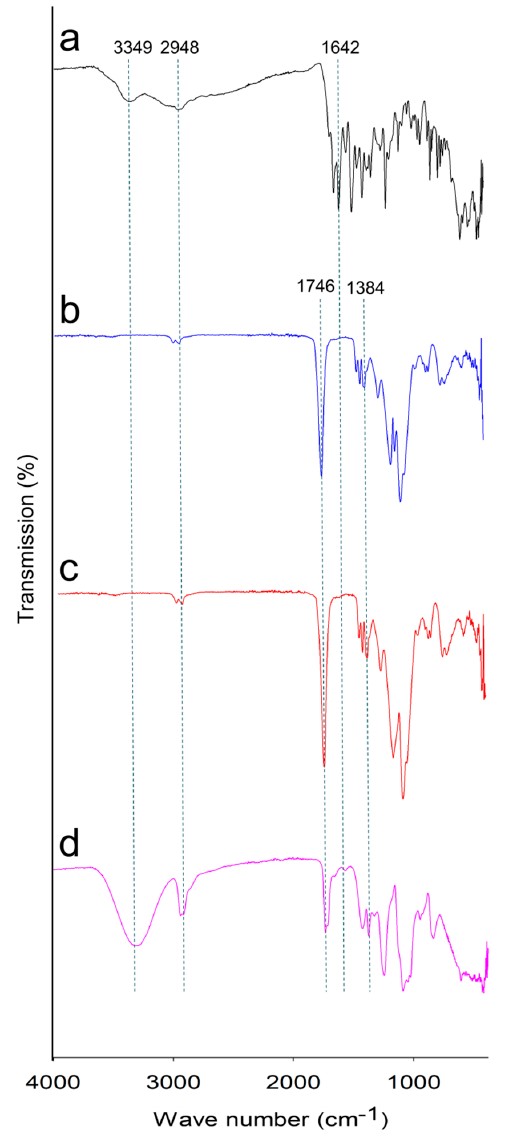
Figure 2. Fourier-transform infrared (FTIR) spectra of methotrexate (MTX) ( a ), poly( D , L -lactide-co-glycolide) (PLGA) ( b ), blank nanoparticles (NPs) ( c ), and MTX-loaded PLGA NPs ( d ).